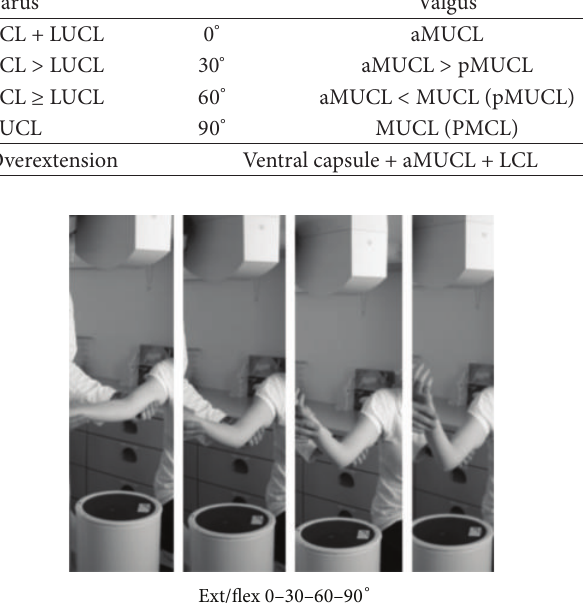
Figure 3: Examination of the elbow joint under intensifier during 0-30-60-90 ∘ of varus and valgus